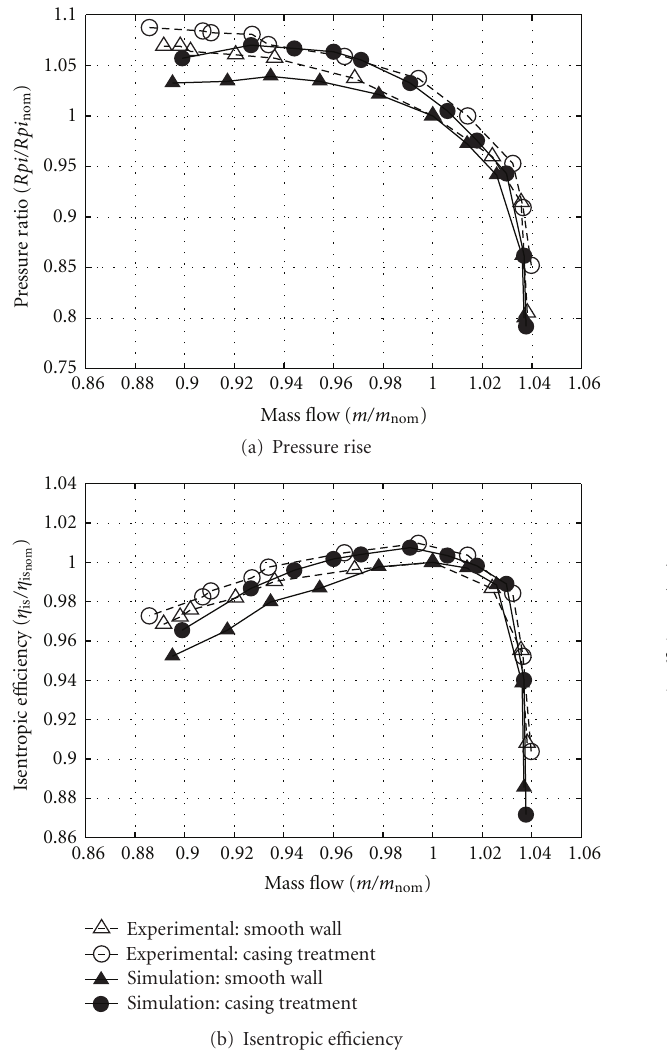
Figure 9: CBUAA characteristics at design speed (experimental ver- sus numerical